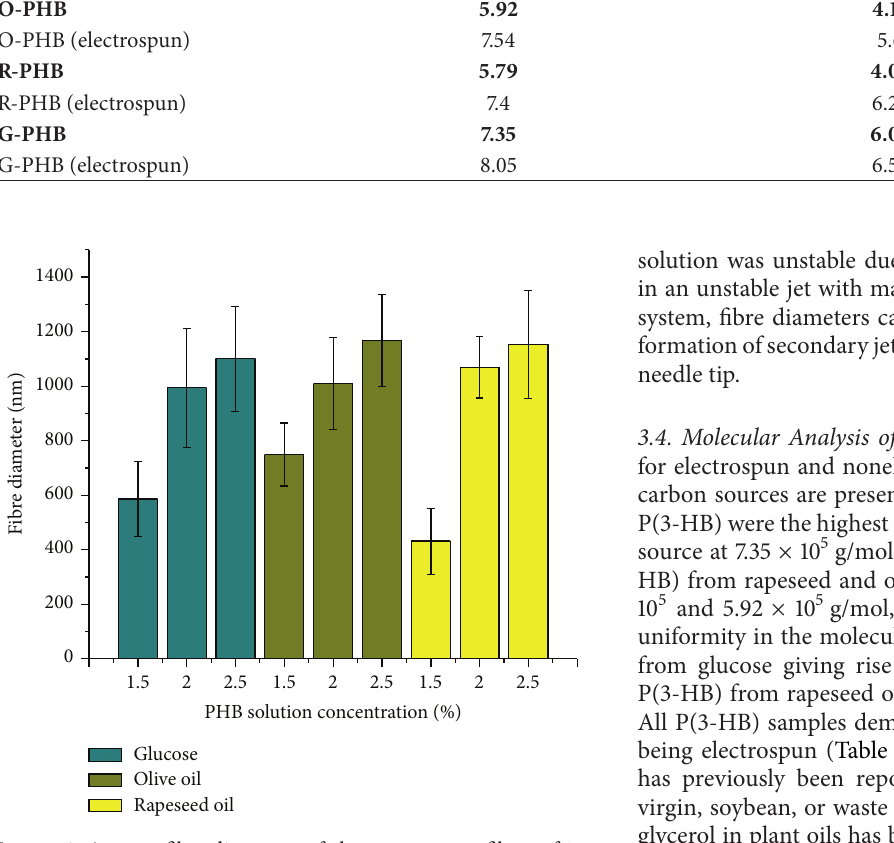
Figure 8: Average fibre diameters of electrospun nanofibres of 1.5, 2, and 2.5% (wt/v) solution concentration of PHB produced by R. eutropha using glucose (G-PHB), olive oil (O-PHB), or rapeseed oil (R-PHB) as carbon source. Applied voltage = 7 kV and needle tip distance = 12.5